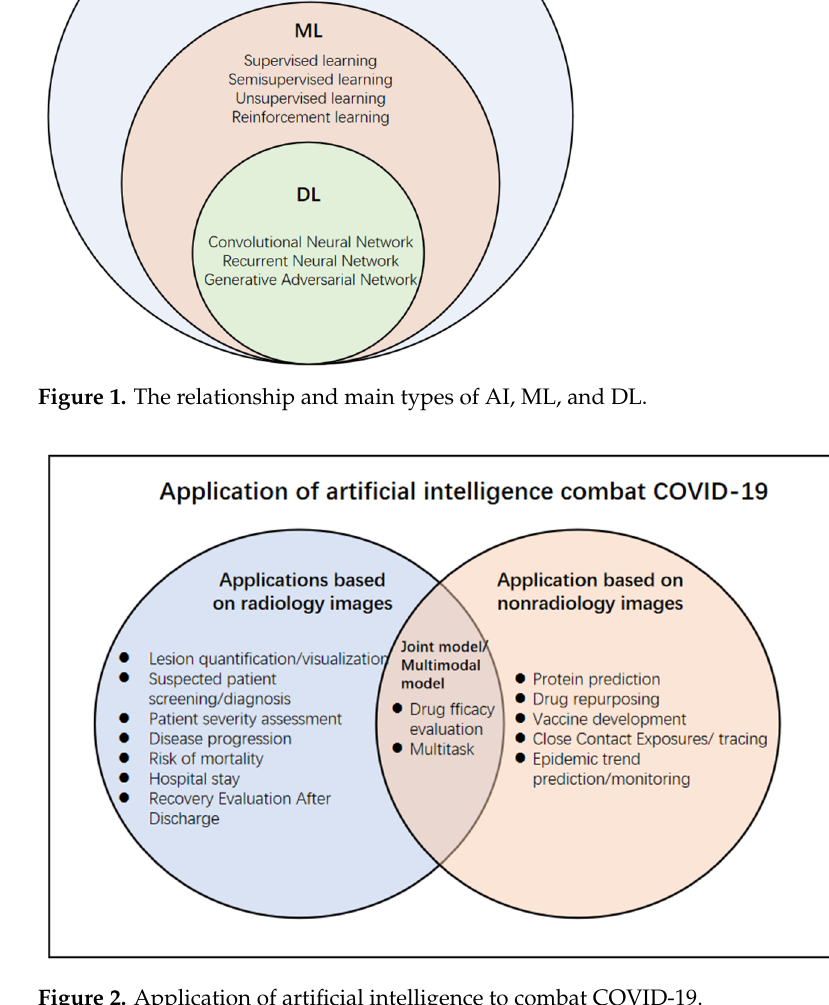
Figure 2. Application of artificial intelligence to combat COVID-19.